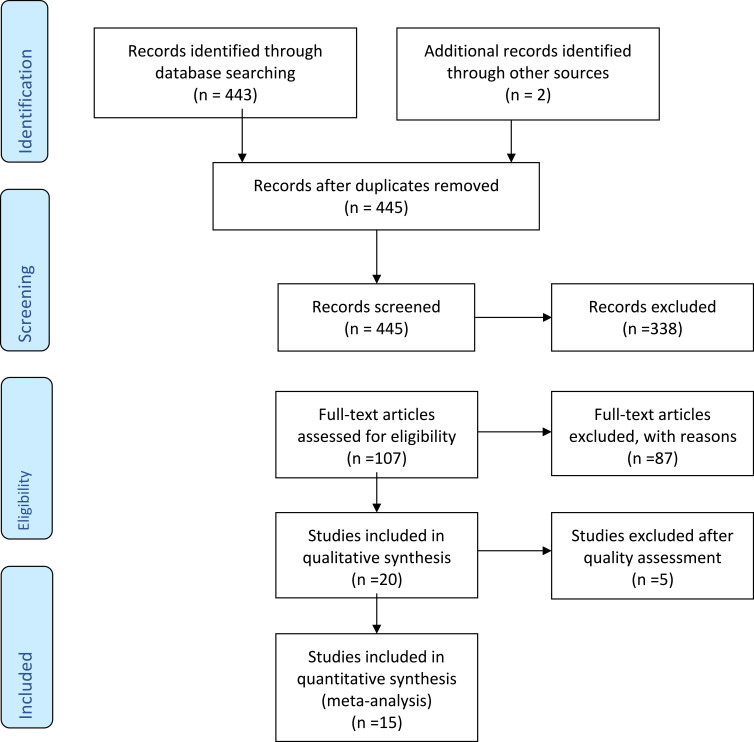
PRISMA flowchart.